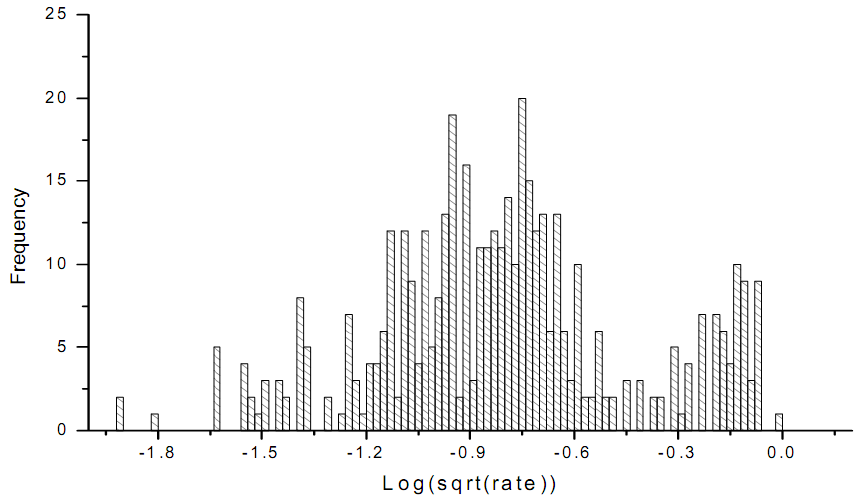
Figure 8. Transformed histogram of crude cultivated land